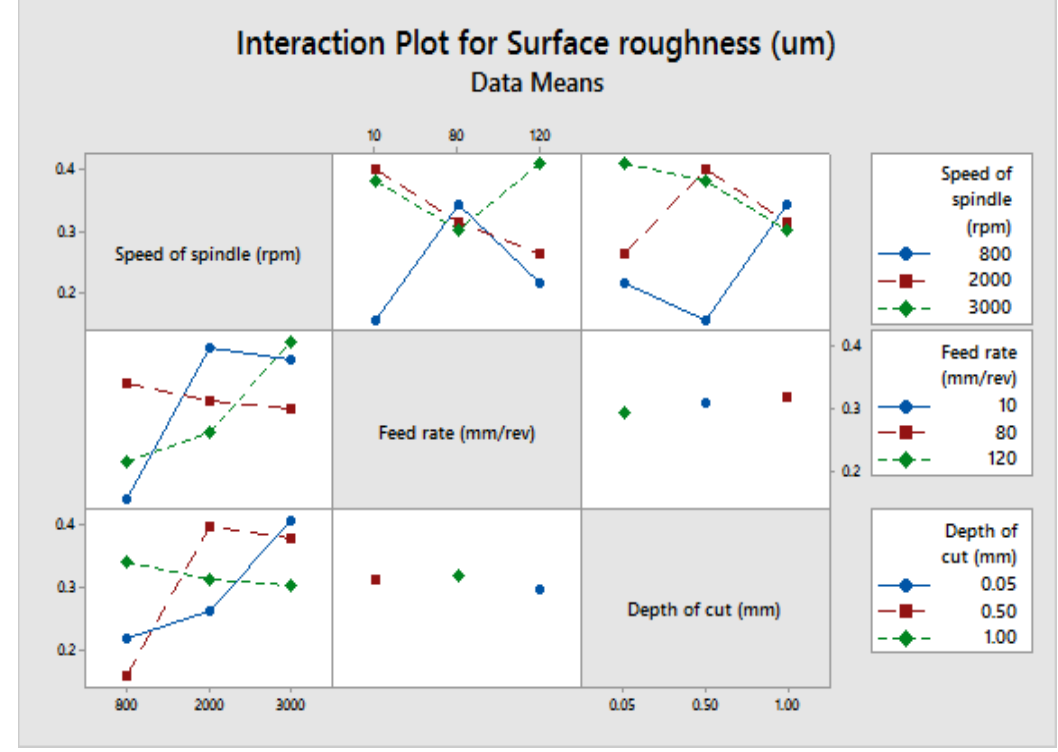
Figure 10. Interaction plot for Ra .